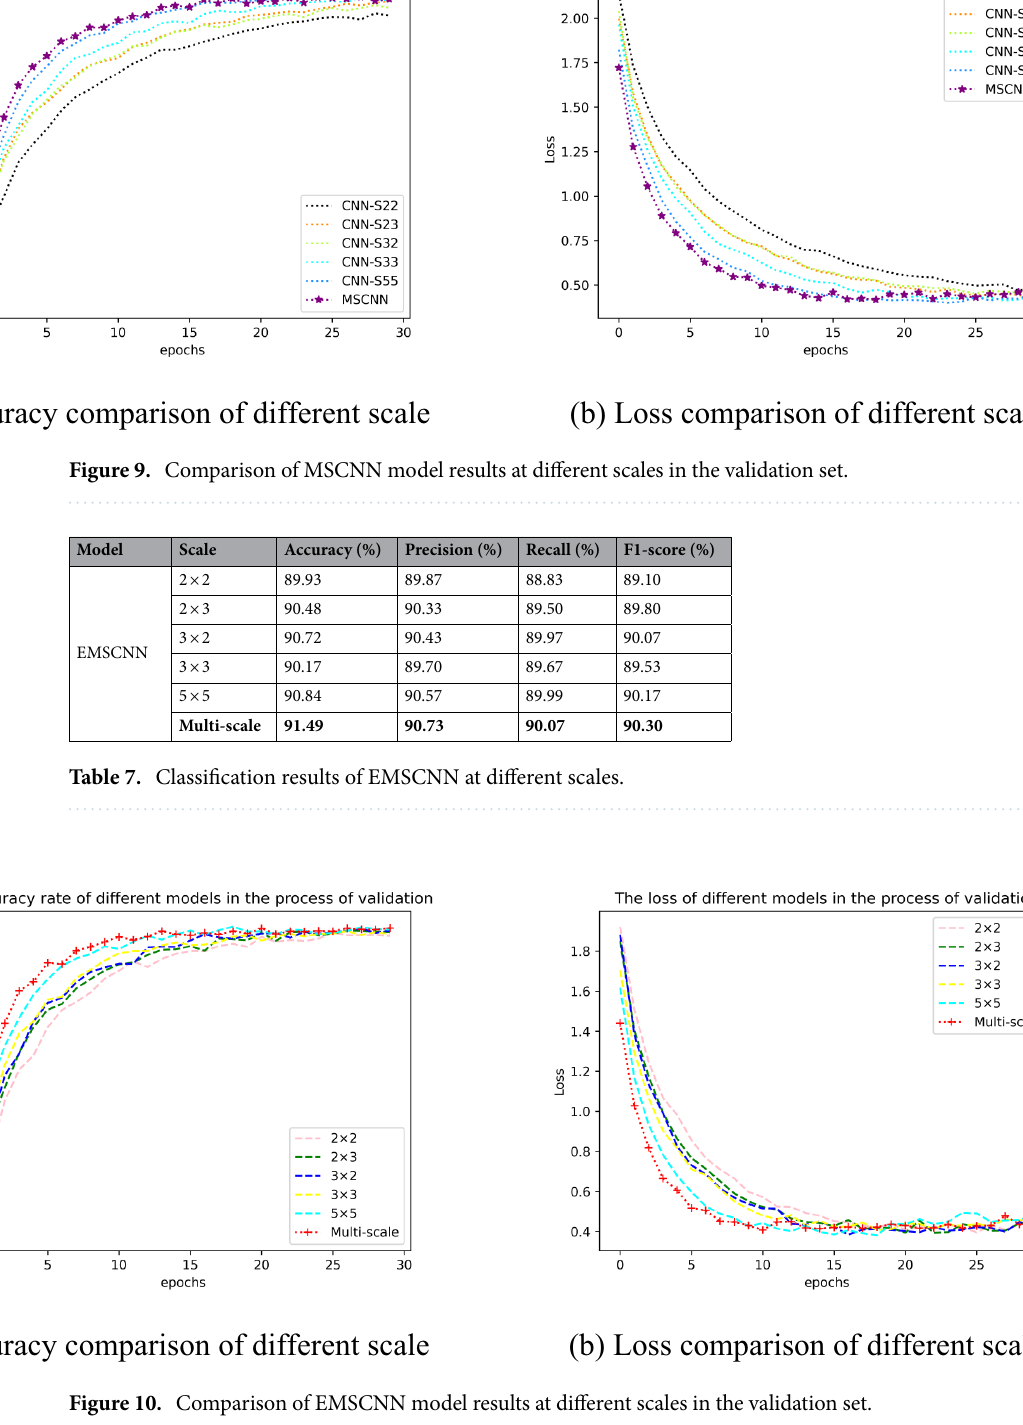
Figure 10. Comparison of EMSCNN model results at different scales in the validation